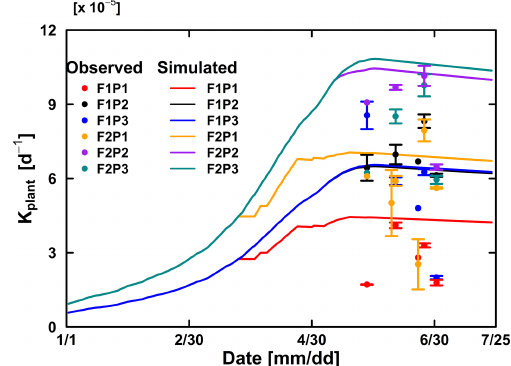
Figure 10. Comparison between observed (dot) and simulated plant hydraulic conductance (solid line) by the Couvreur (Co) model in the sheltered (P1), rainfed (P2), and irrigated (P3) plots of the stony soil (F1) and the silty soil (F2). The vertical bars represent the stan- dard deviation of six hourly plant hydraulic conductance values at around midday (11:00 to 16:00LT) on the measurement day. Note that crop germination was on 26 October 2015; data are shown here from 1 January to harvest on 23 July 2016. The blue line was over- lapped by the black